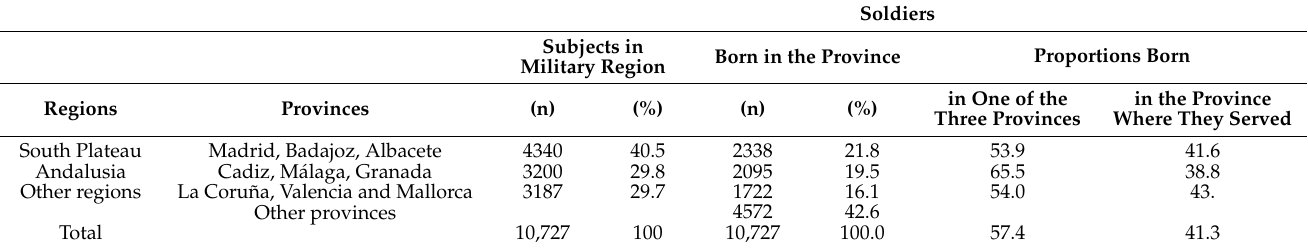
Table 2. Distribution of examined soldiers by region of deployment and place of birth. Soldiers Subjects in Military Region Born in the